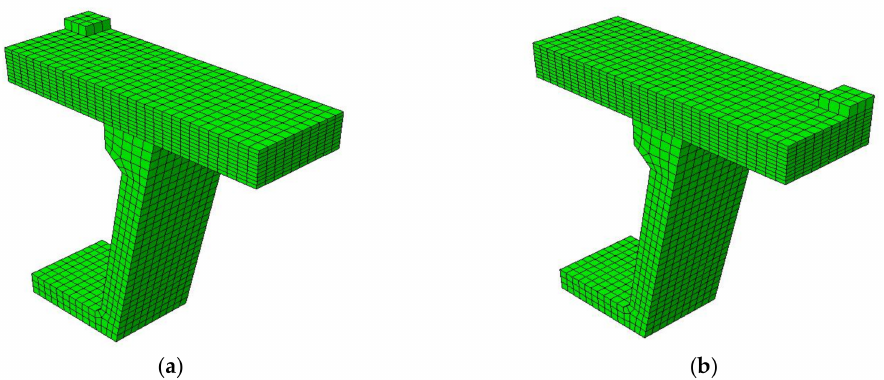
Figure 10. The finite element model for Thompson Bridge. ( a ) Loading for the slab between the W-beams in the finite element model; ( b ) Loading for the slab between W-beams and W-beams in the finite element